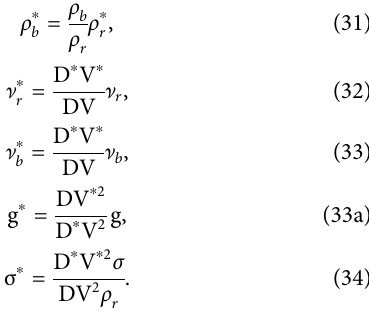
Figure 2 , where the interface between the corium and the